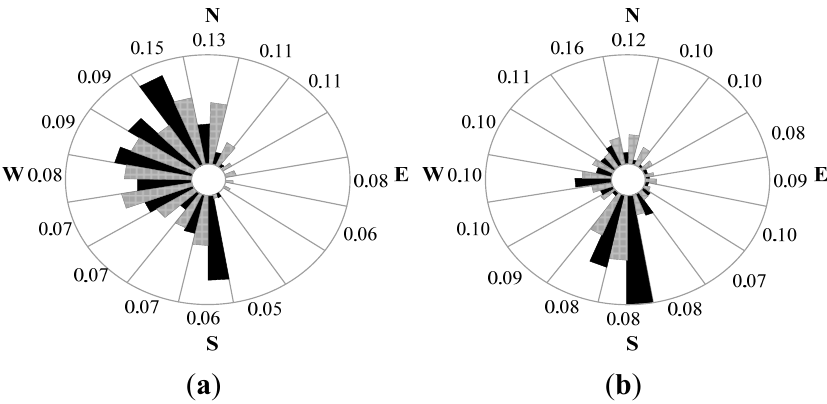
Figure 1. Wind rose for ( a ) the month of February and ( b ) for the month of March.